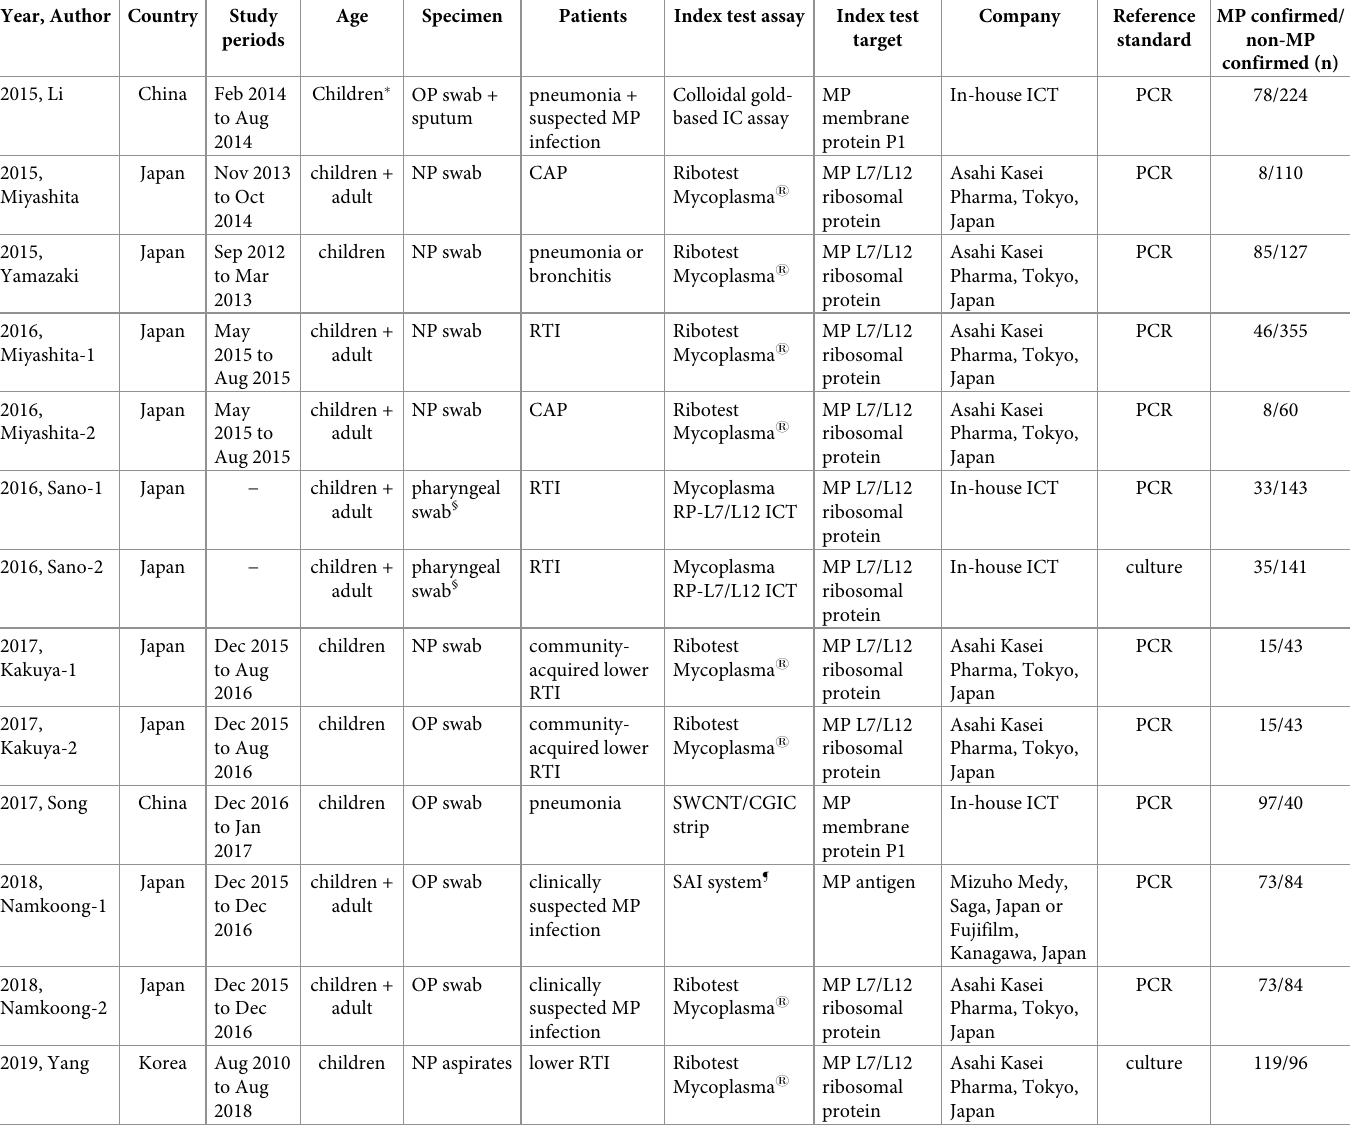
Table 1. Characteristics of the studies included in the